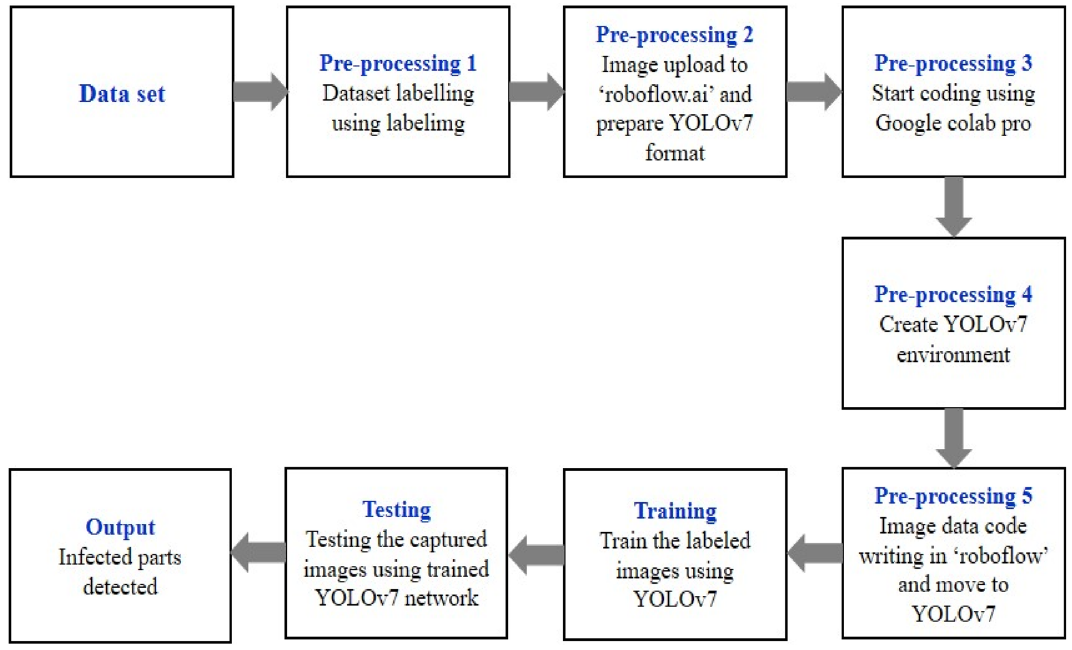
Figure 4. Block diagram of training and testing the proposed YOLOv7 model.